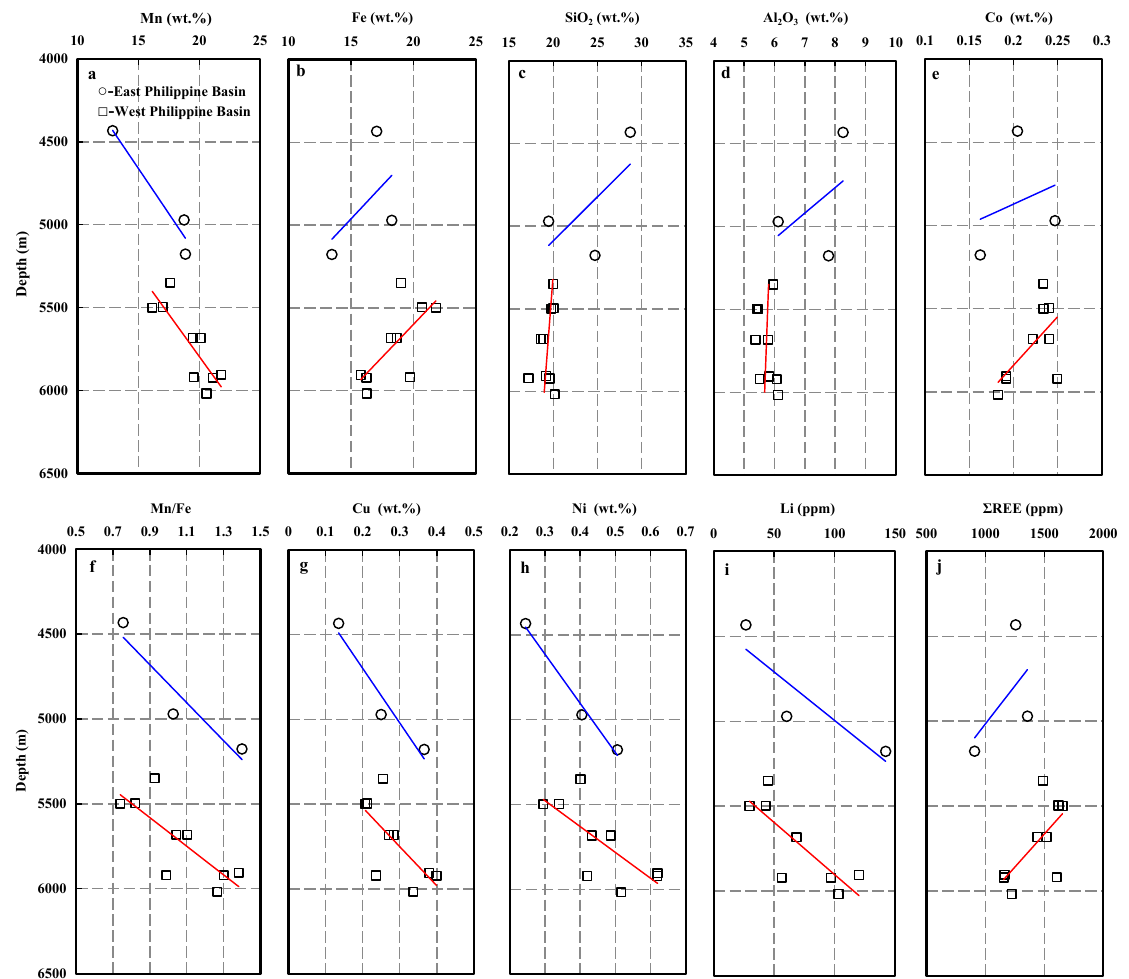
Figure 5. ( a – j ): plots of elements (Mn, Fe, SiO 2 , Al 2 O 3 , Co, Mn/Fe, Cu, Ni, Li, and Σ REE; from bulk analyses) concentrations of samples from the Philippine Sea versus the water depths (n = 12; Table 1). Blue lines show linear regressions of the East Philippine Sea nodules, while red lines show linear regressions of the West Philippine Sea nodules.